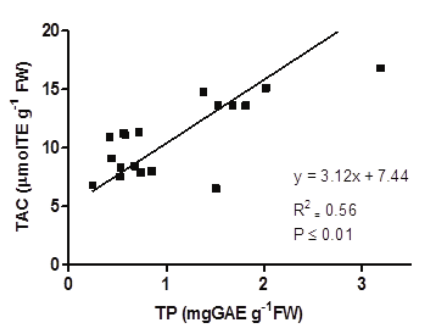
Fig. 3 - Linear regression between total antioxidant capacity (TAC) and total phenols (TP) of the studied varieties